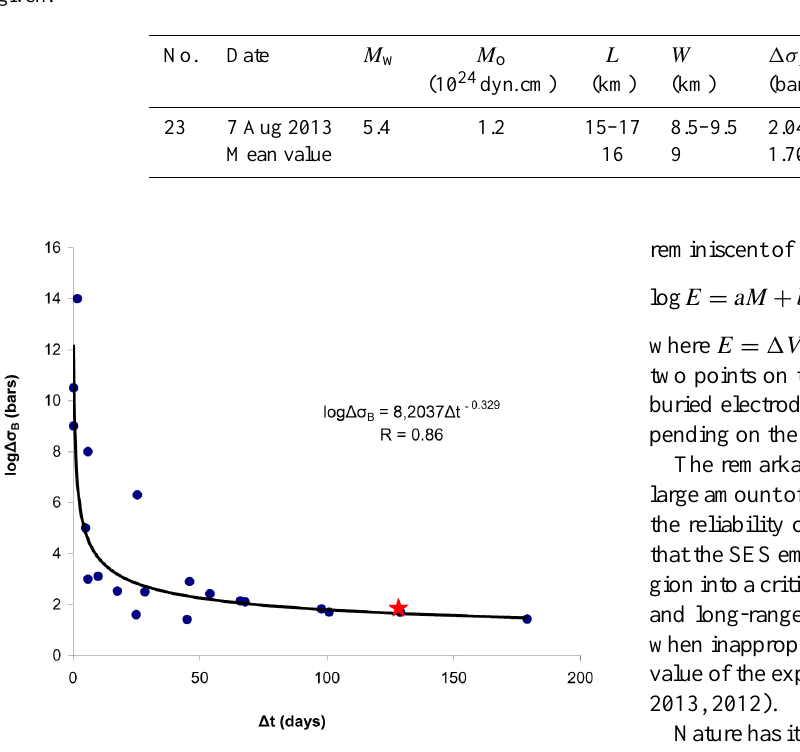
Fig. 2. The plot of the power law between the stress drop of the earthquakes and the lead time of SES. A red star corresponds to the new data (Table 1, no. 23), while solid circles refer to the data sets reported in Table 2 of Dologlou (2013). The new derived power law relation along with its correlation coefficient R and the exponent α = 0 . 329 are displayed on the top of the